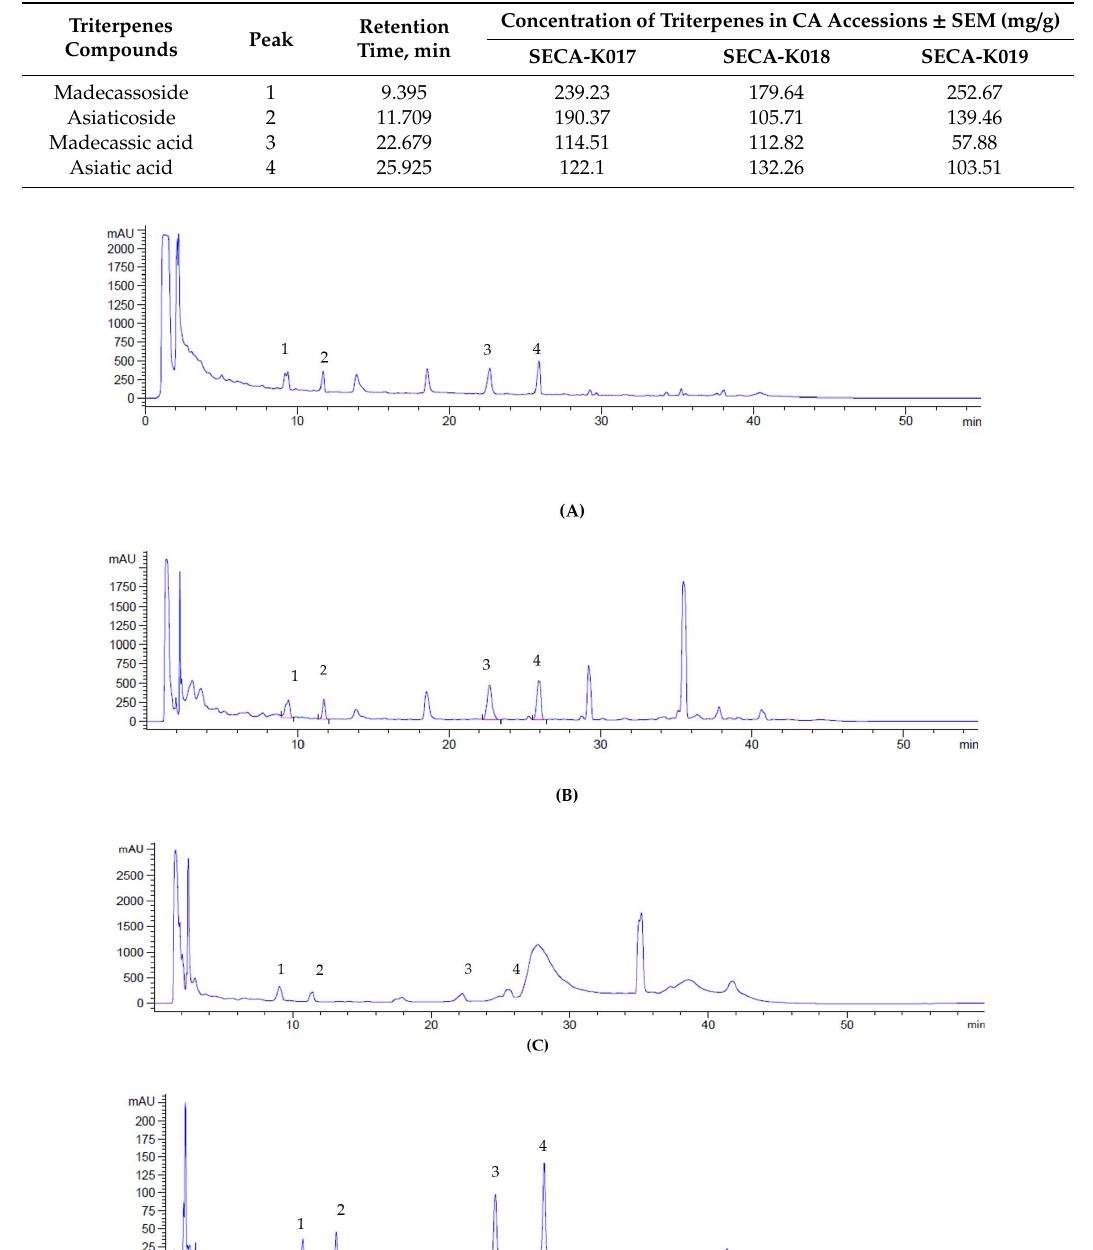
Table 3. Triterpenes content of standardized extracts of CA accessions.